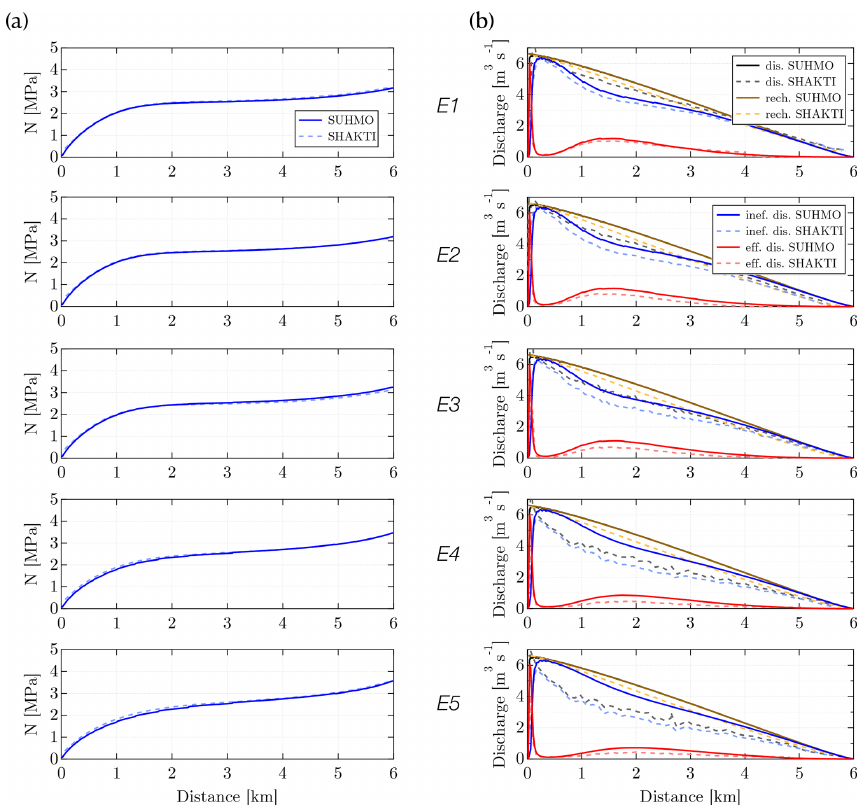
Figure 7. Steady-state results for the SHMIP suite of test cases E: (a) y -average evolution of effective pressure N with distance from the outlet and (b) volumetric discharge, to be compared to the total recharge the system receives (see text for further explanation). The contributions from the inefficient and efficient systems (their sum gives the total discharge) are also featured. For validation purposes, results from SHAKTI (Sommers et al., 2018) as presented in de Fleurian et al. (2018) are also